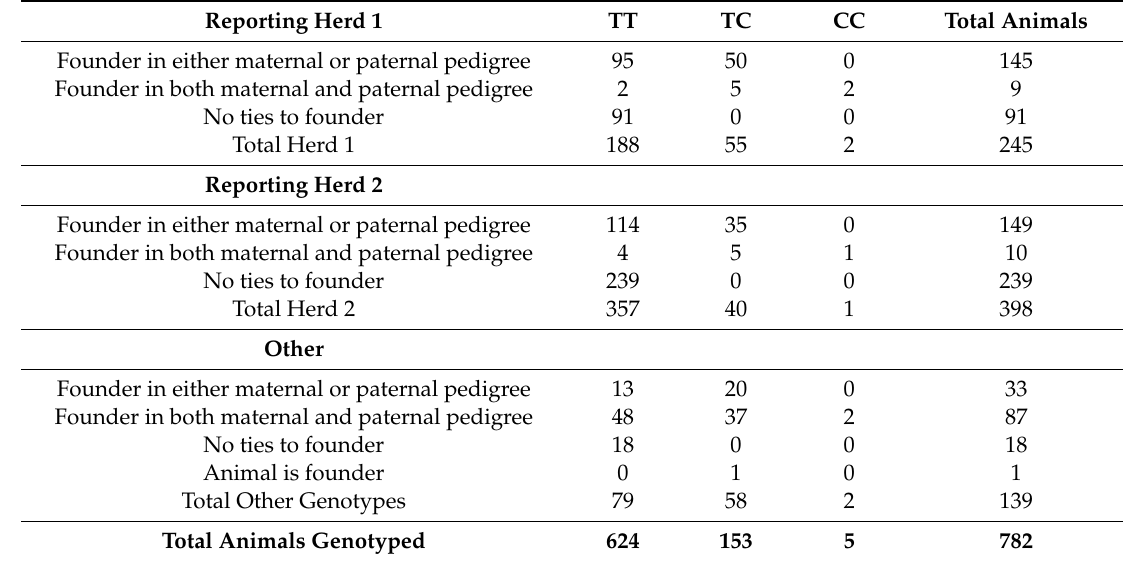
Table 3. Genotyping of the variant Chr26 g. 14404993T > C. Given is the count of individuals by classification for each genotype. All animals with the CC genotype were a ff ected with MD. All parents of a ff ected MD calves had a TC